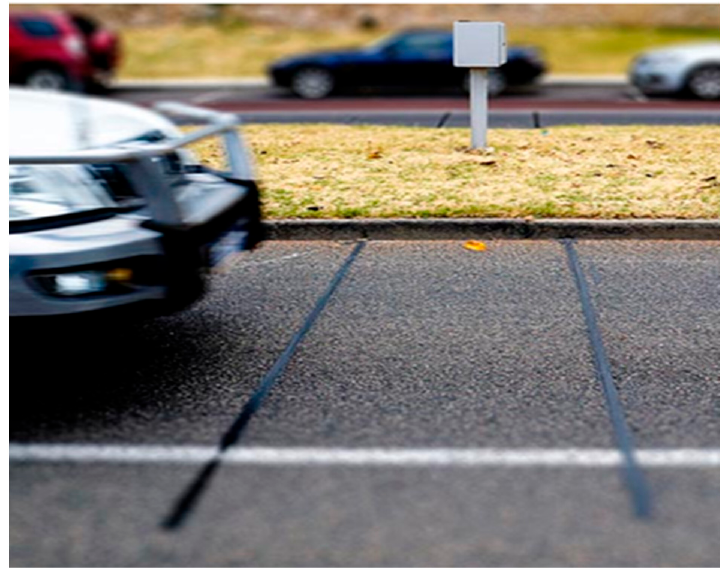
Figure 5. The black lines on the road surface are the inductive loop detectors.